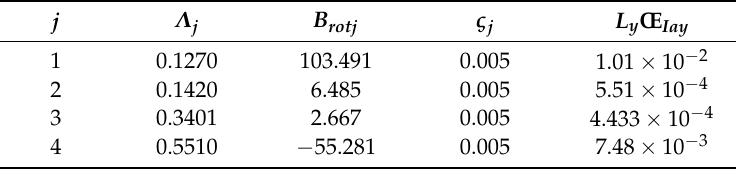
Table 1. The modal parameters of pitch axis.